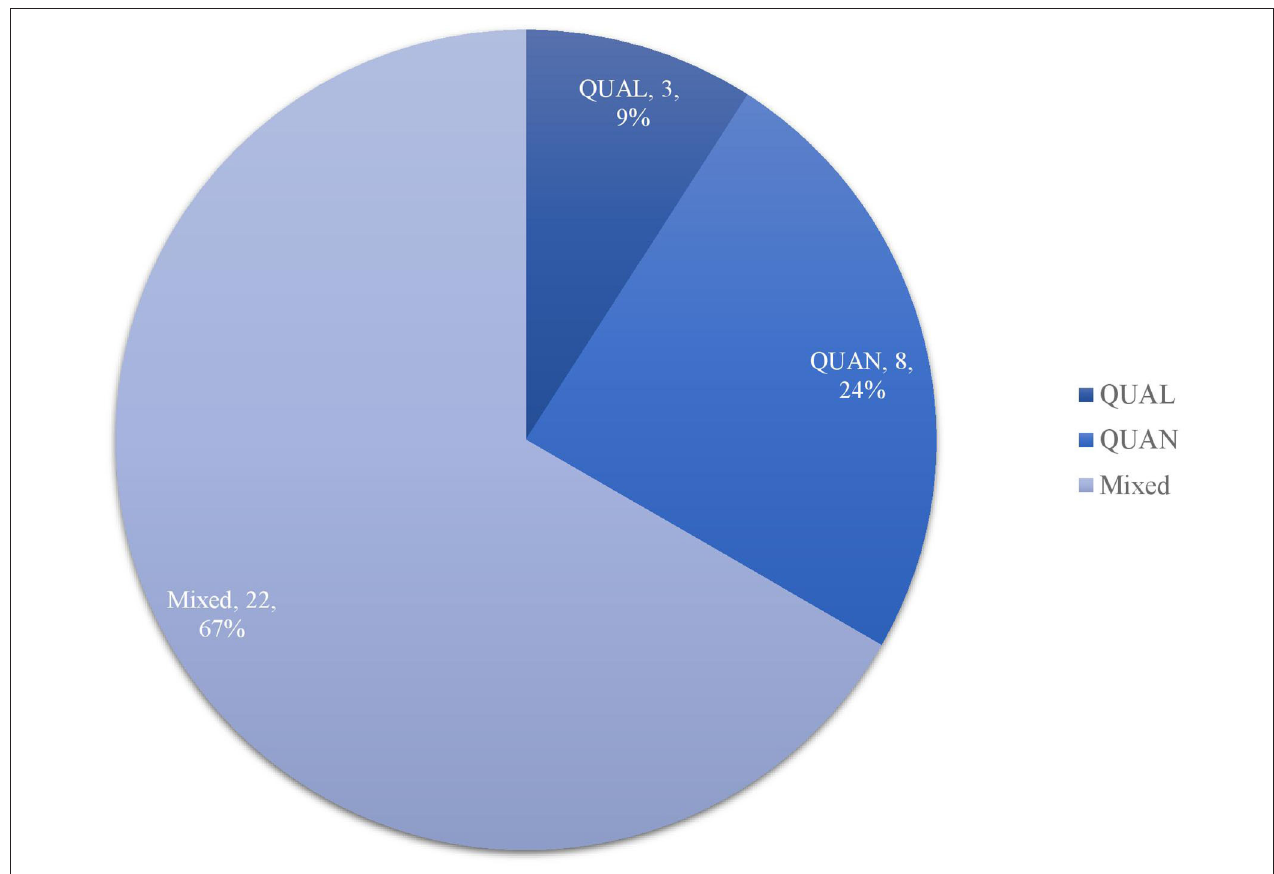
FIGURE 5 | Distribution of articles conducted using three methodological